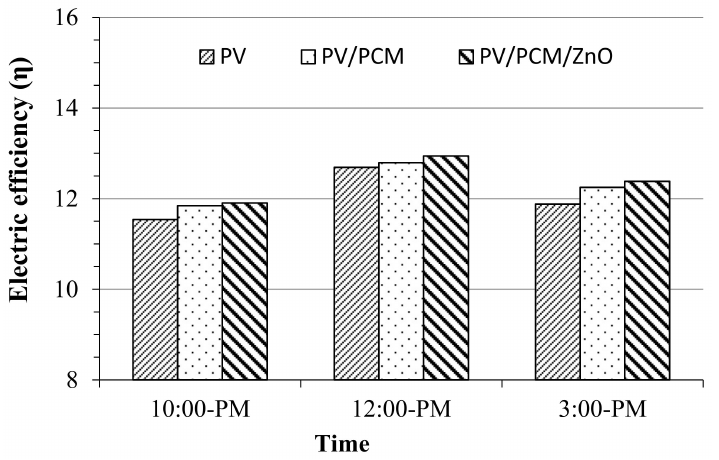
Figure 6. Conversion efficiency of different PV systems obtained at 10:00 a.m., 12:00 p.m., and 3:00